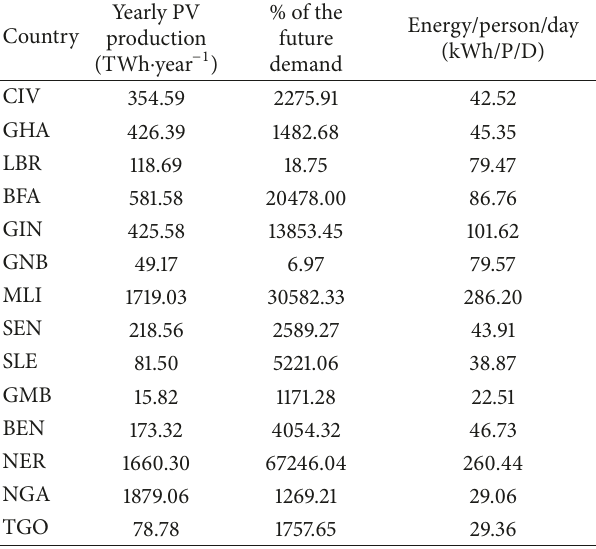
Table 4: Energy potentiality of ECOWAS